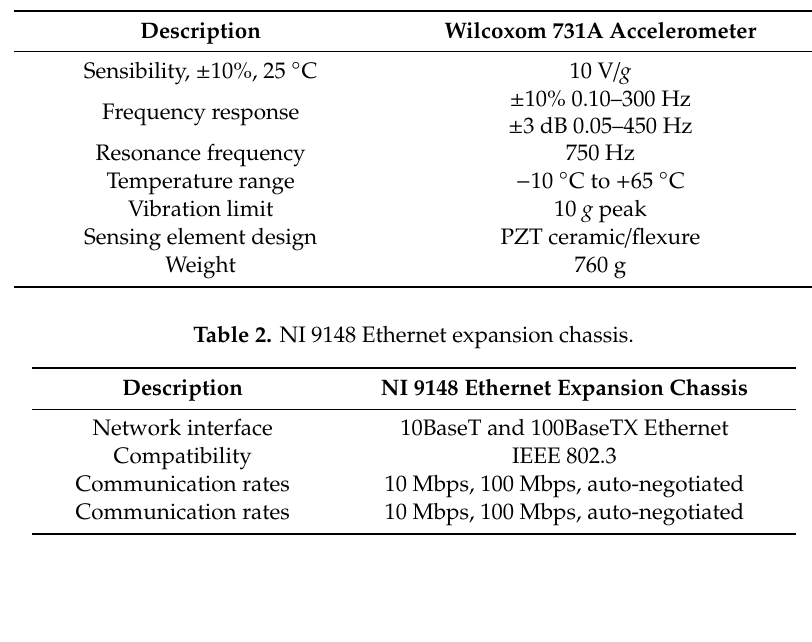
Table 1. Wilcoxon 731A accelerometer characteristics.